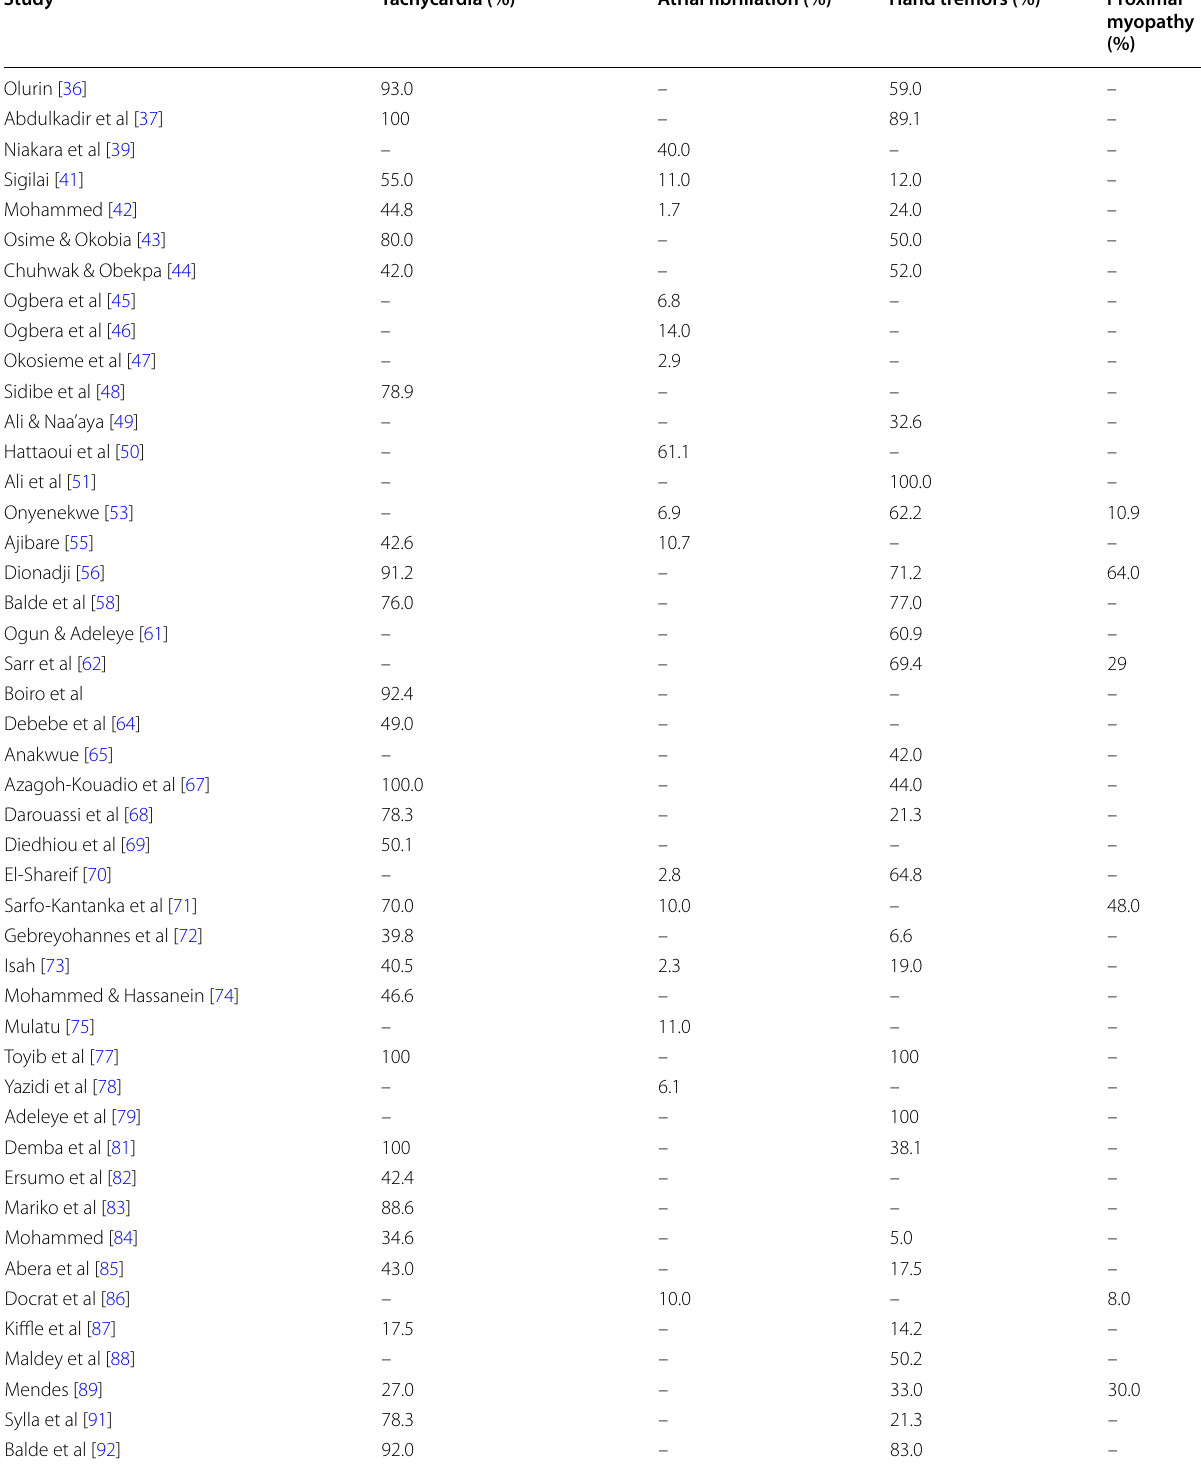
Table 8 Cardiovascular and neurological signs of